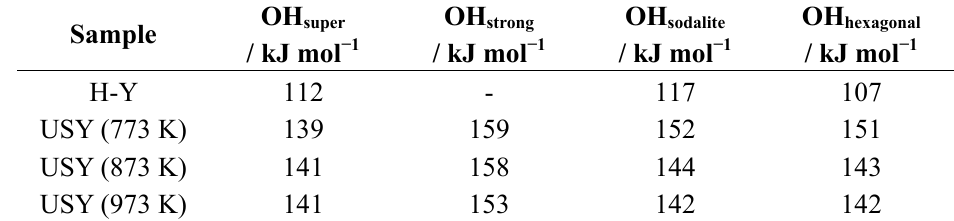
IRMS-TPD methods. 3